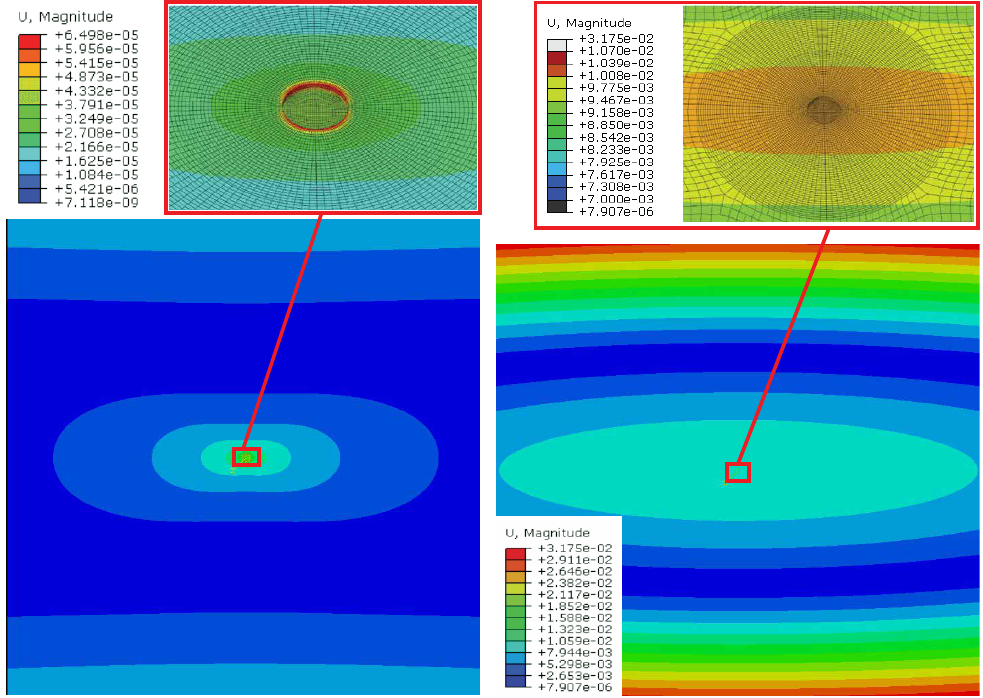
Figure 11. Displacements’ distributions on the specimen’s